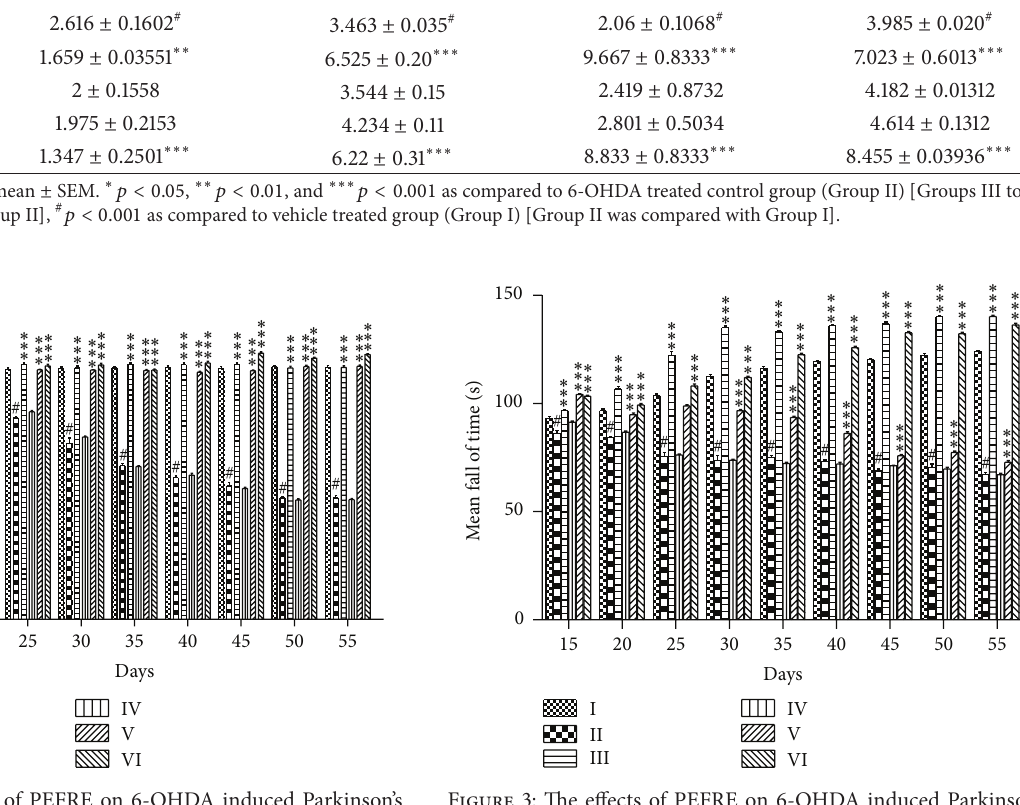
Figure 3: The effects of PEFRE on 6-OHDA induced Parkinson’s disease in the rotarod performance. Group I: vehicle control group; Group II: 6-OHDA treated group; Group III: Levodopa + 6-OHDA treated group; Group IV: PEFRE (100mg/kg) + 6-OHDA treated group; Group V: PEFRE (200 mg/kg) + 6-OHDA treated group; Group VI: PEFRE (400 mg/kg) + 6-OHDA treated group. ∗∗∗ 𝑝 < 0.001 as compared to 6-OHDA treated negative control group (Group II). # 𝑝 < 0.001 6-OHDA treated negative control group (Group II) compared to vehicle treated control group (Group